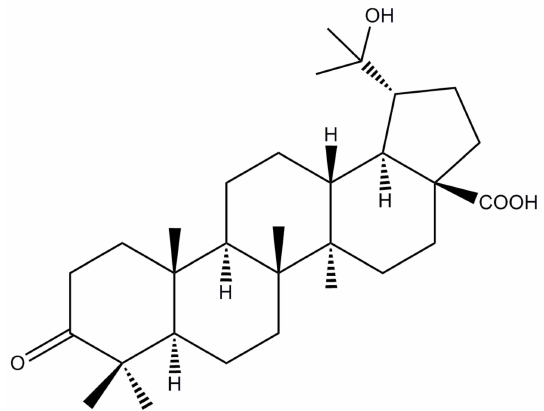
Figure 1. The structure of 20-hydroxy-3-oxolupan-28-oic acid